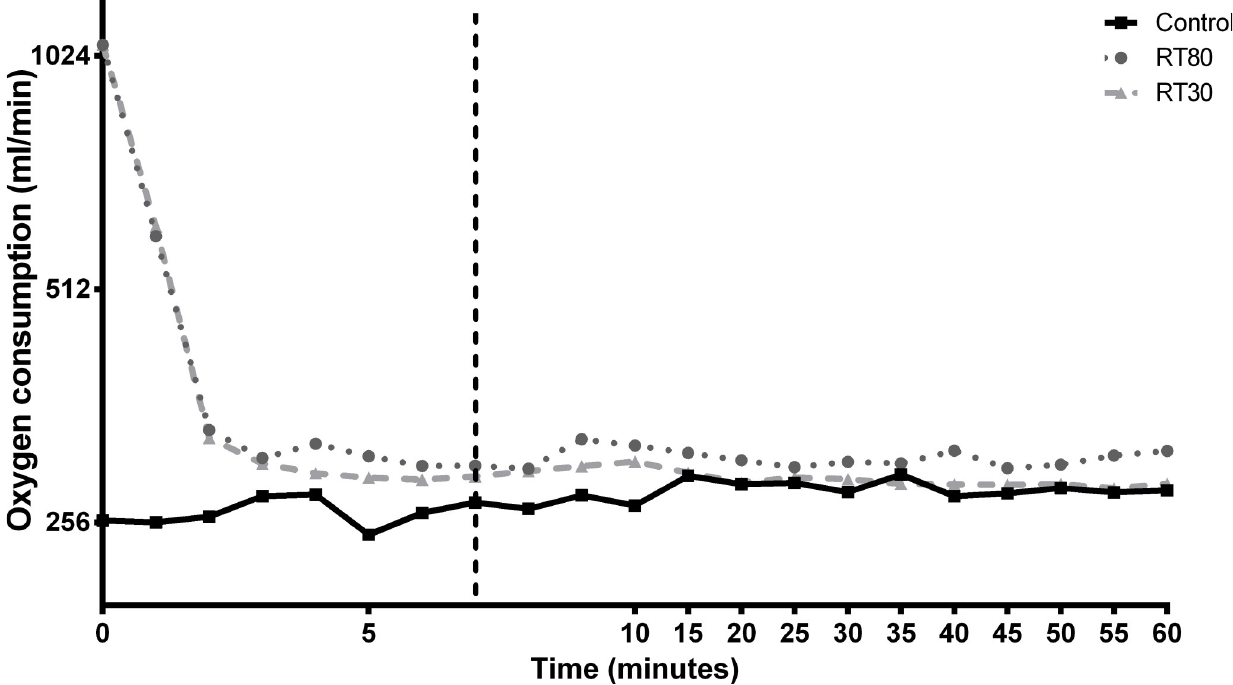
Fig 2. Schematic evaluation of excess post-exercise oxygen consumption (EPOC) from a low-load (30% of 1RM; RT30) or a high-load (80% of 1RM; RT80) RT protocol performed to momentary failure or a control session without exercise (Control). The dashed line represents the initial 7 minutes of recovery used for the calculation of the anaerobic alactic system contribution of the exercise. Individual data points presented in S1 Dataset.